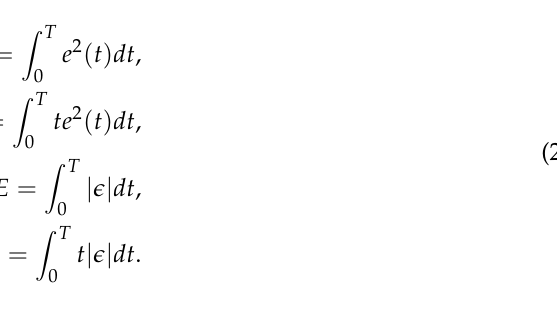
Table 4. Performance indices, integral of the square of the error (ISE), integral of time into squared error (ITSE), integral absolute error (IAE) and integral time absolute error (ITAE) values for PID and SMC.